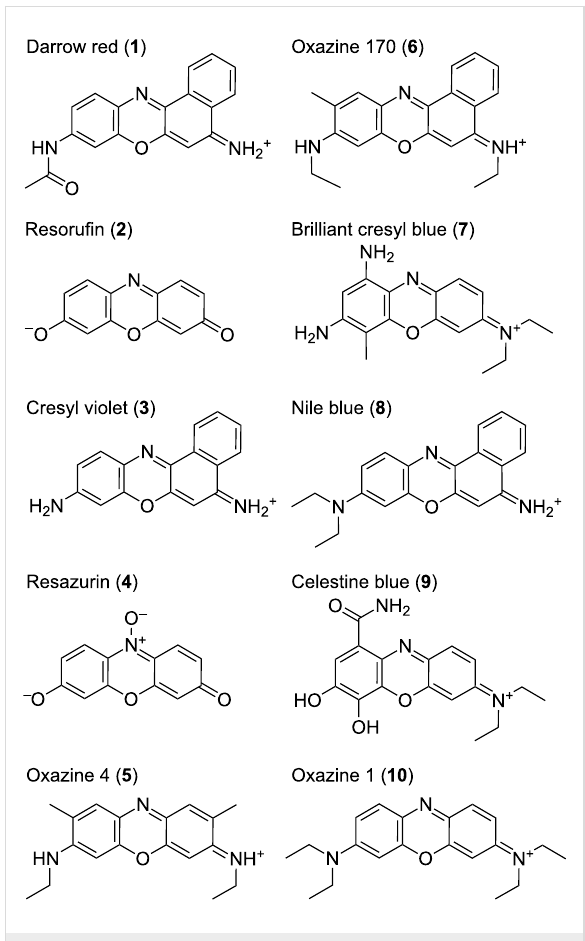
Figure 2: Numbering and structure of oxazine dyes studied in this work (counterions not shown).